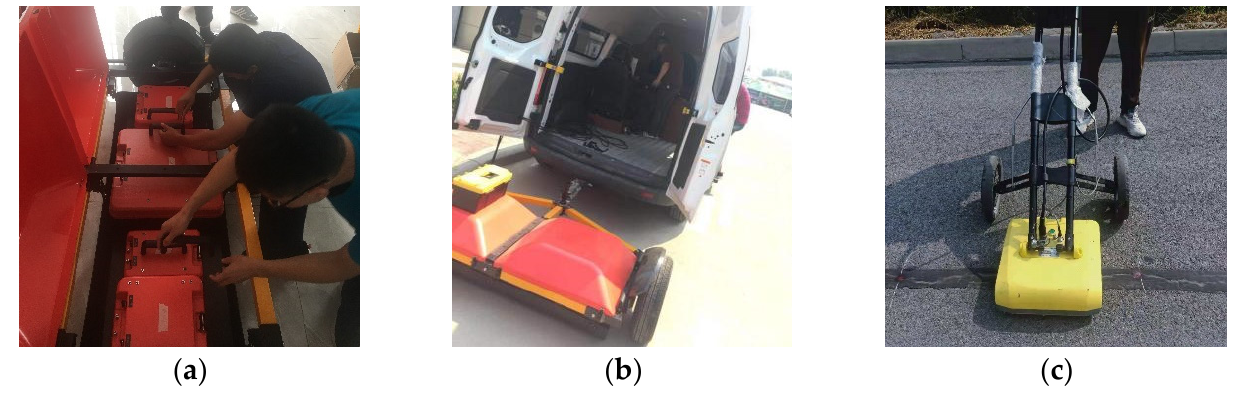
Figure 6. ( a ) The four-channel GPR system ( b ) GPR system was mounted on a vehicle; ( c ) the hand-towed GPR device.